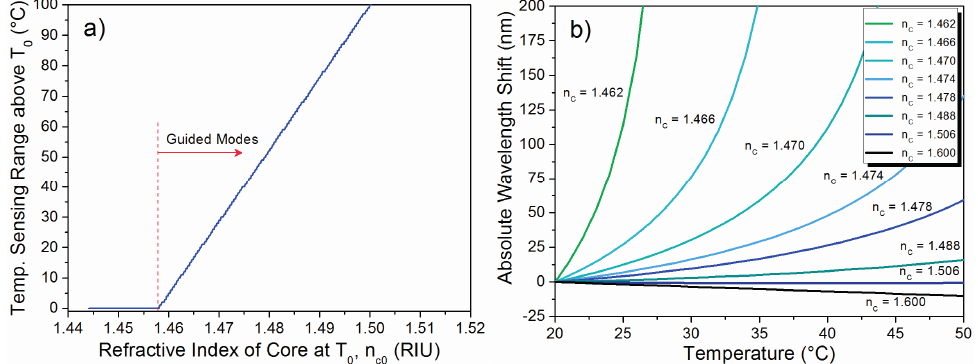
Figure 2. ( a ) Temperature sensing range in which guided modes exists; ( b ) Absolute wavelength shift of the MMI spectral response for different liquid core refractive